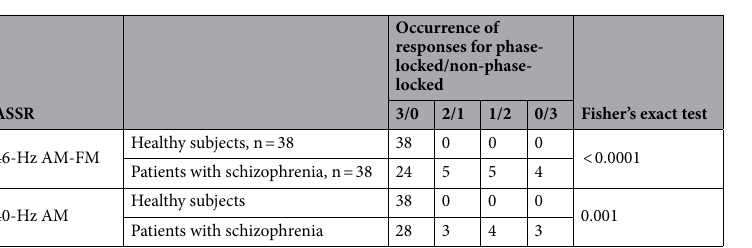
Table 1. Occurrence of the phase-locked and non-phase-locked responses in thrice measurements of 40-Hz ASSR.